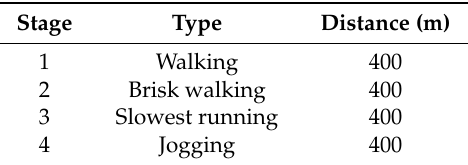
Figure 11. Experimental photo of field test. Table 3. Procedure for field